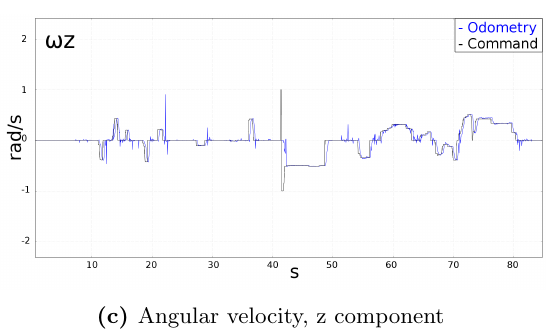
Figure 9: Velocity commands and raw odometry from a six-wheeled